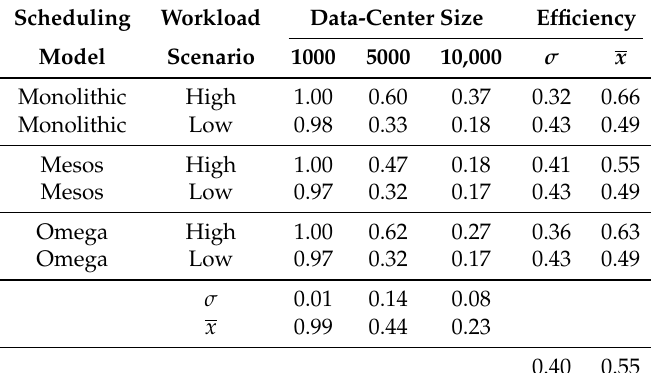
Table 3. Efficiency analysis for data-center